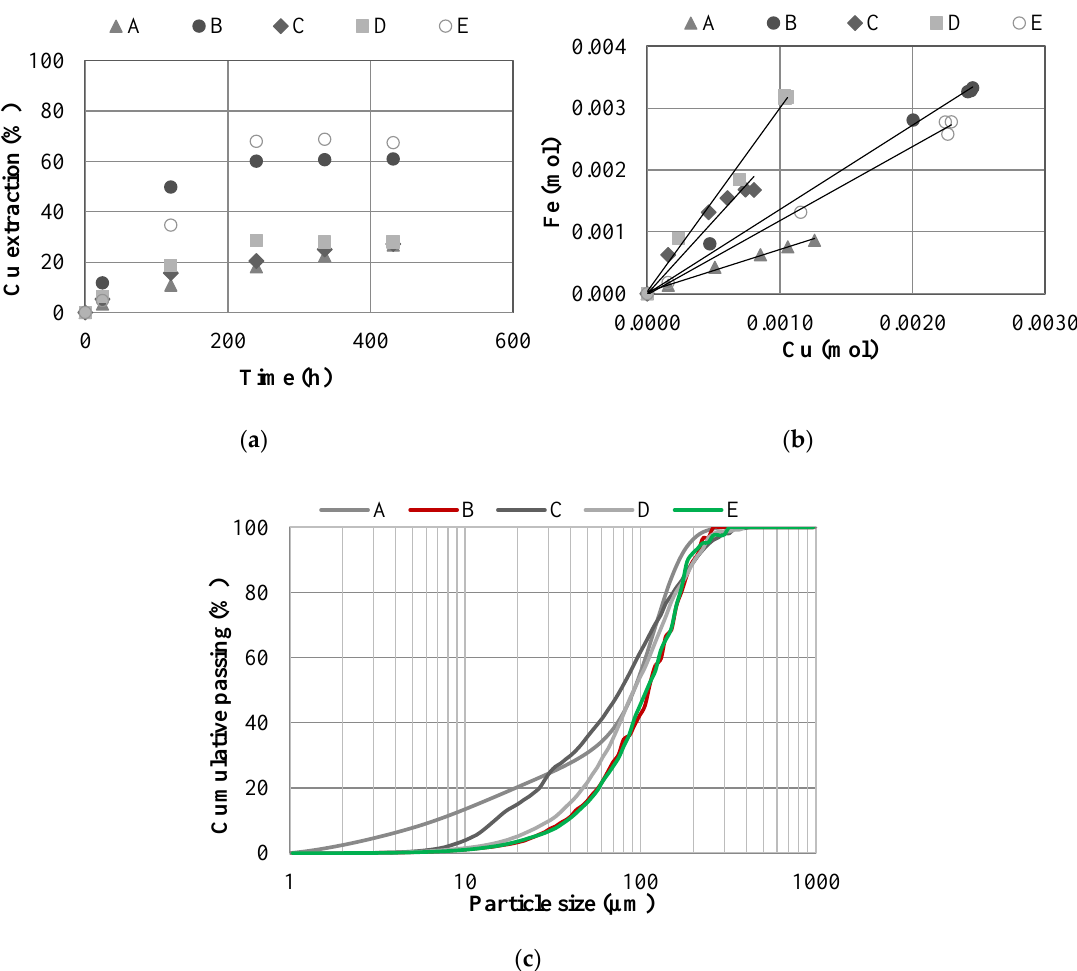
Figure 10. ( a ) Copper extraction (%) versus time (h) when different chalcopyrite samples were used: A, B, C, D, and E. ( b ) Cu/Fe molar ratio when different chalcopyrite samples were used: A, B, C, D, and E. ( c ) Particle size distribution of samples: A, B, C, D, and E after the experiments. Experimental conditions: [NaNO 3 ] = 0.7 M, [H 2 SO 4 ] = 0.7 M, seawater as dissolvent, −150 + 75 µ m, S/L ratio 2 g/L, 45 °C, 350 rpm.